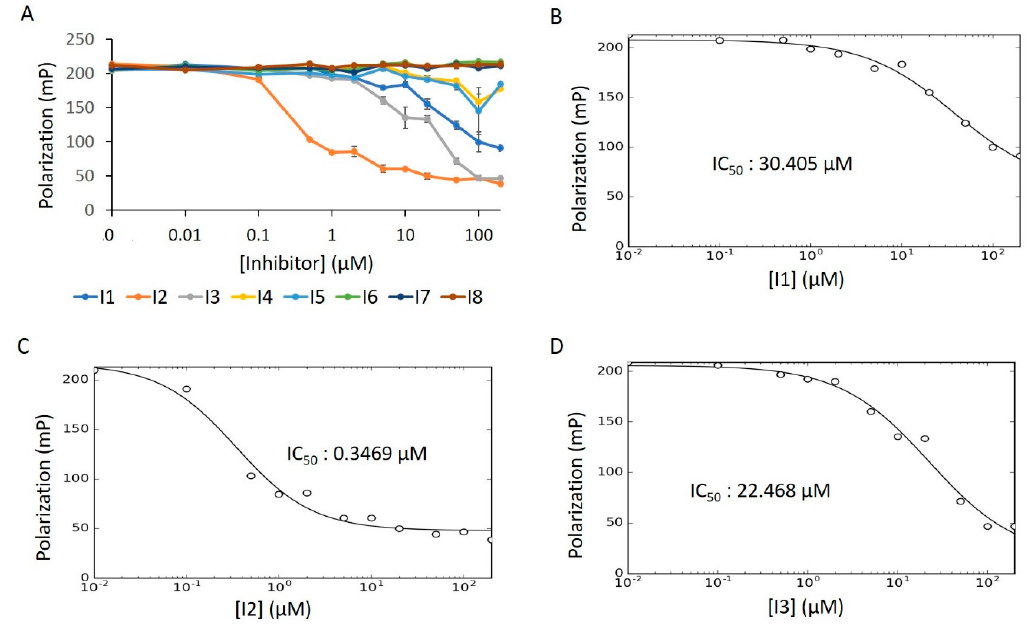
Figure 13. E234G HYPE inhibitor concentration–response curve. ( A ) FP plots from ∆ 102 E234G HYPE AMPylation reactions incubated with 0 to 200 µ M of DMSO-dissolved inhibitors. ( B – D ) Data from ( A ) fitted to Equation (6) (see Methods) to determine IC 50 values. All reactions were done in buffer containing 0.1% Triton X-100.